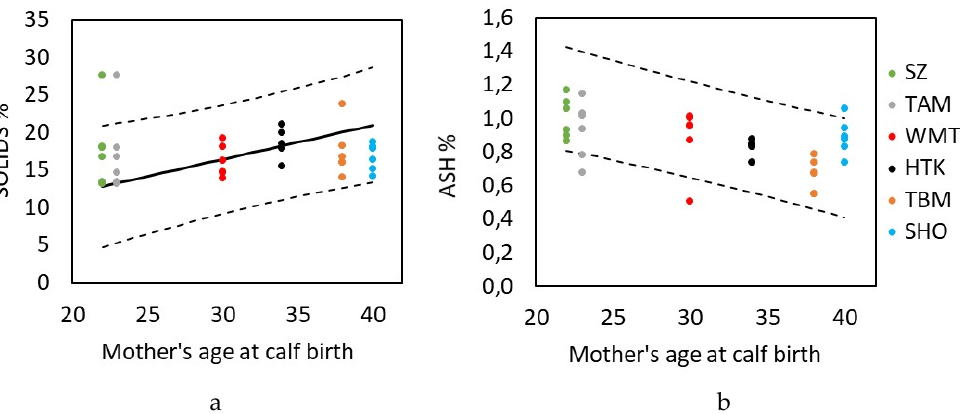
Figure 3. Variation in milk components with maternal age at calf birth. Solids components ( a ) increased with greater maternal age whereas ( b ) ash components in late lactation milk. Points represent raw data for different mothers and solid lines show predicted values from the model with CLs (dashed lines). Predicted values drawn from the model according to reference categories and captive-born mothers.